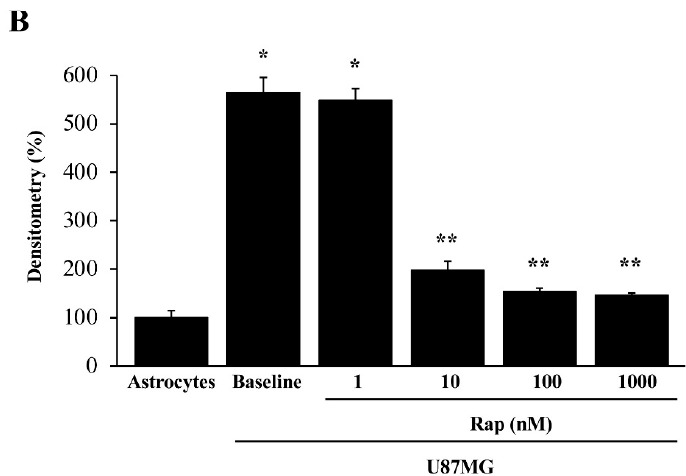
Figure 8. Rapamycin dose-dependently reduces α -syn and nestin immuno-fluorescence in GBM cells to an amount, which is similar to baseline astrocytes. Graphs report densitometry for α -syn ( A ) and nestin ( B ) immuno-fluorescence within baseline astrocytes and GBM cells, both in baseline conditions (baseline) and following various doses of rapamycin (Rap). Data are given as the mean percentage ± S.E.M. of optical density for each experimental group (assuming astrocytes as 100%) obtained from N = 30 cells per group. * p < 0.05 compared with astrocytes. ** p < 0.05 compared with astrocytes and GBM cells (U87MG) in baseline conditions.